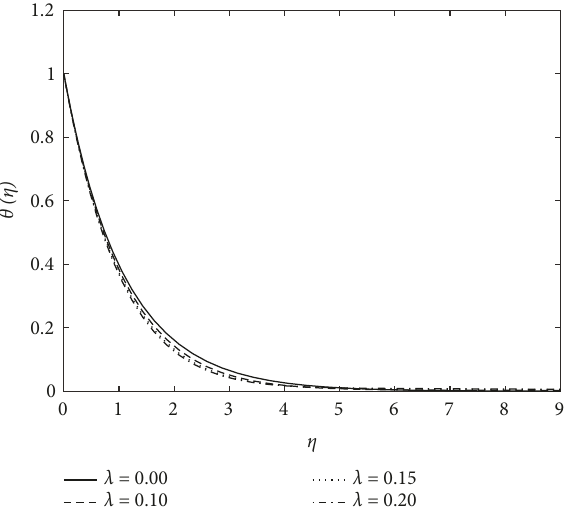
Figure 8: Change in the value of θ ( η ) for different values of Pr.